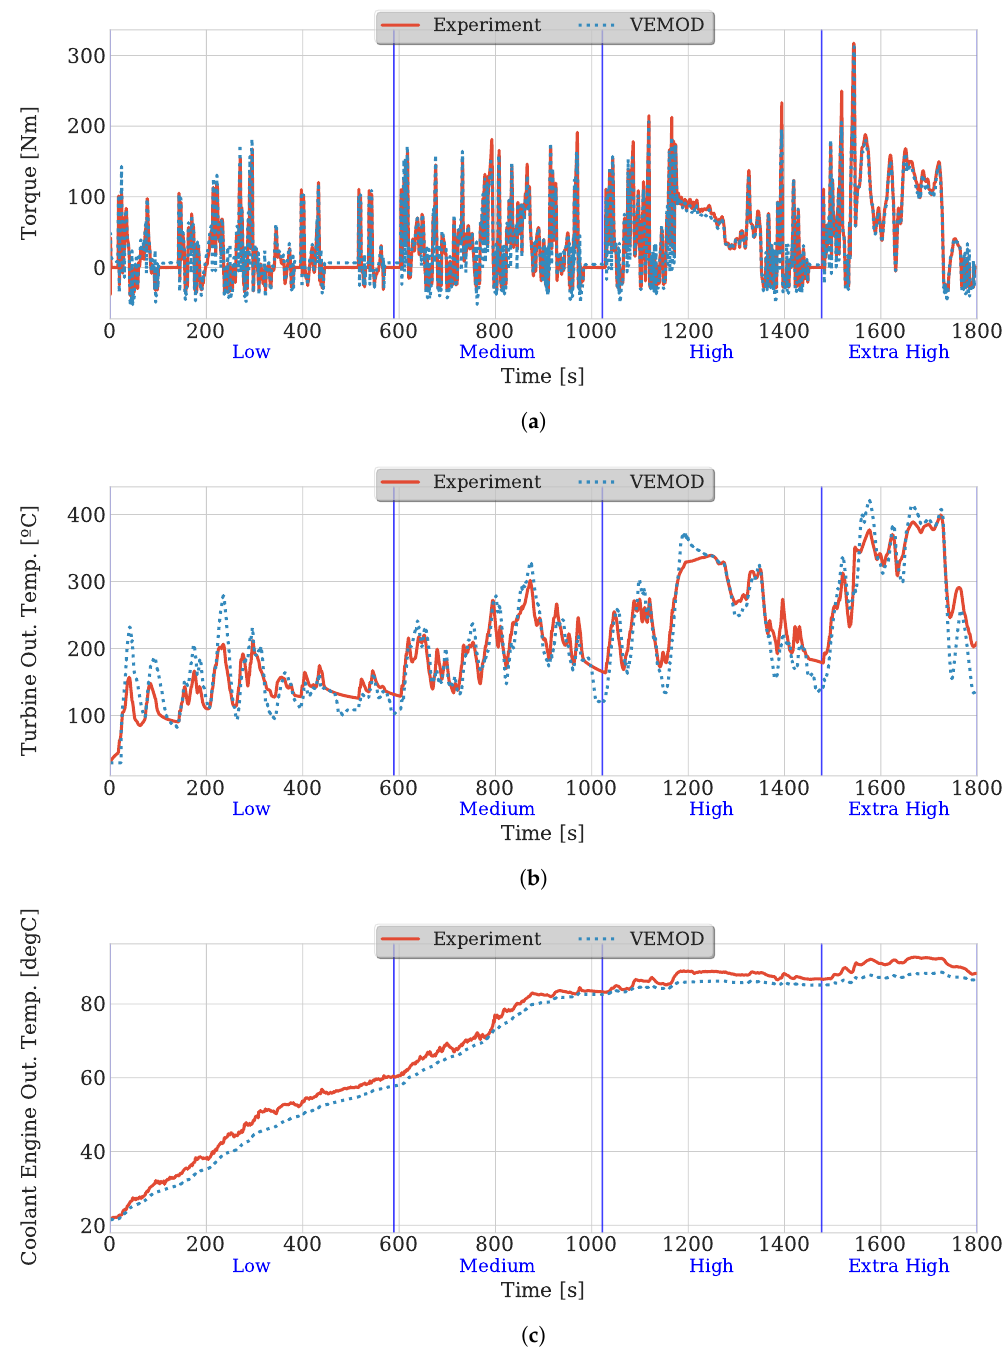
Figure 5. WLTC model validation, engine start at 20 ◦ C room temperature. ( a ) Brake torque; ( b ) EAT inlet temperature; ( c ) Coolant temperature at engine